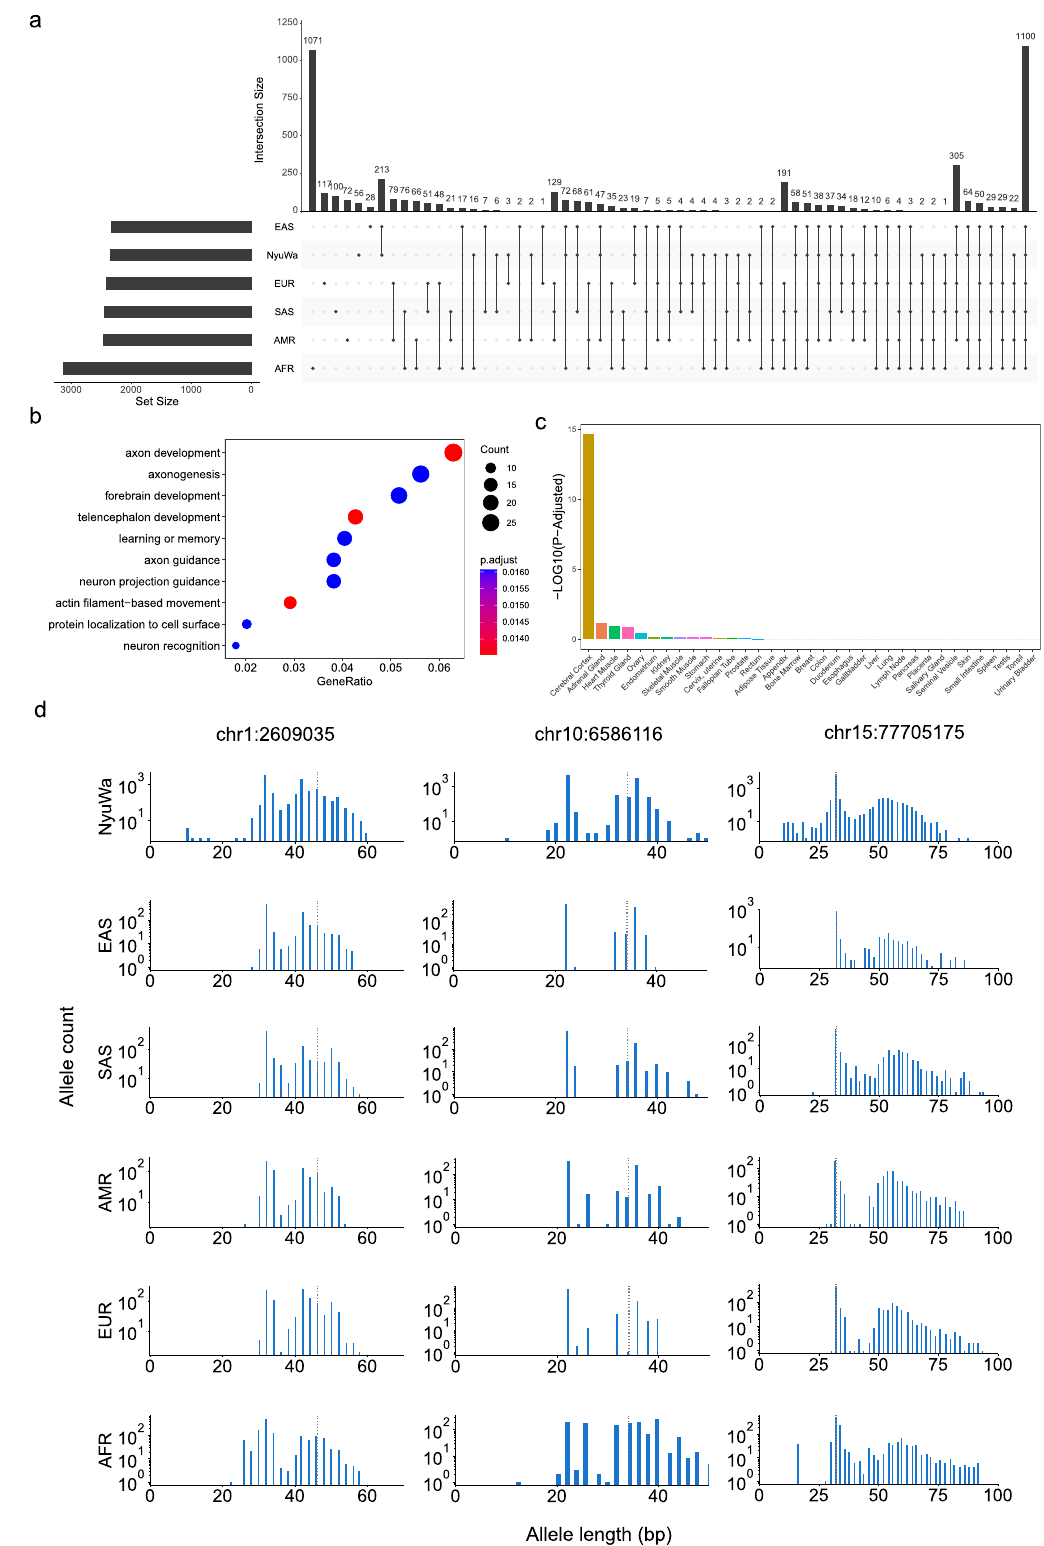
Fig. 7 | Highly variable pSTRs within superpopulations. a UpSet plot of highly variablepSTRsidenti fi edfromtheNyuWadatasetand the fi vesuperpopulationsin the 1KGP. b Gene Ontology (GO) enrichment analysis for genes enclosing 1110 highlyvariablepSTRsdetectedinallsuperpopulations.Thetoptenmostsigni fi cant items are shown. c Bar plot showing the adjusted p value of tissue-speci fi c gene